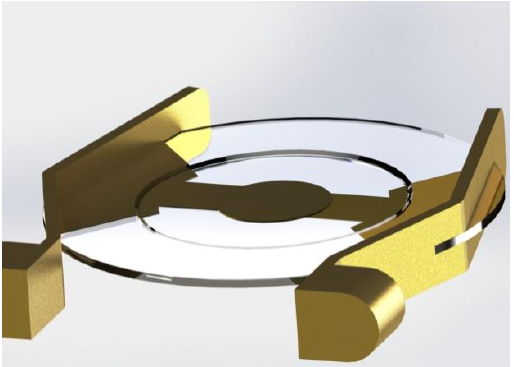
Figure 3. Schematic view of a high fundamental frequency quartz oszillator (diameter of the quartz disk approx. 5